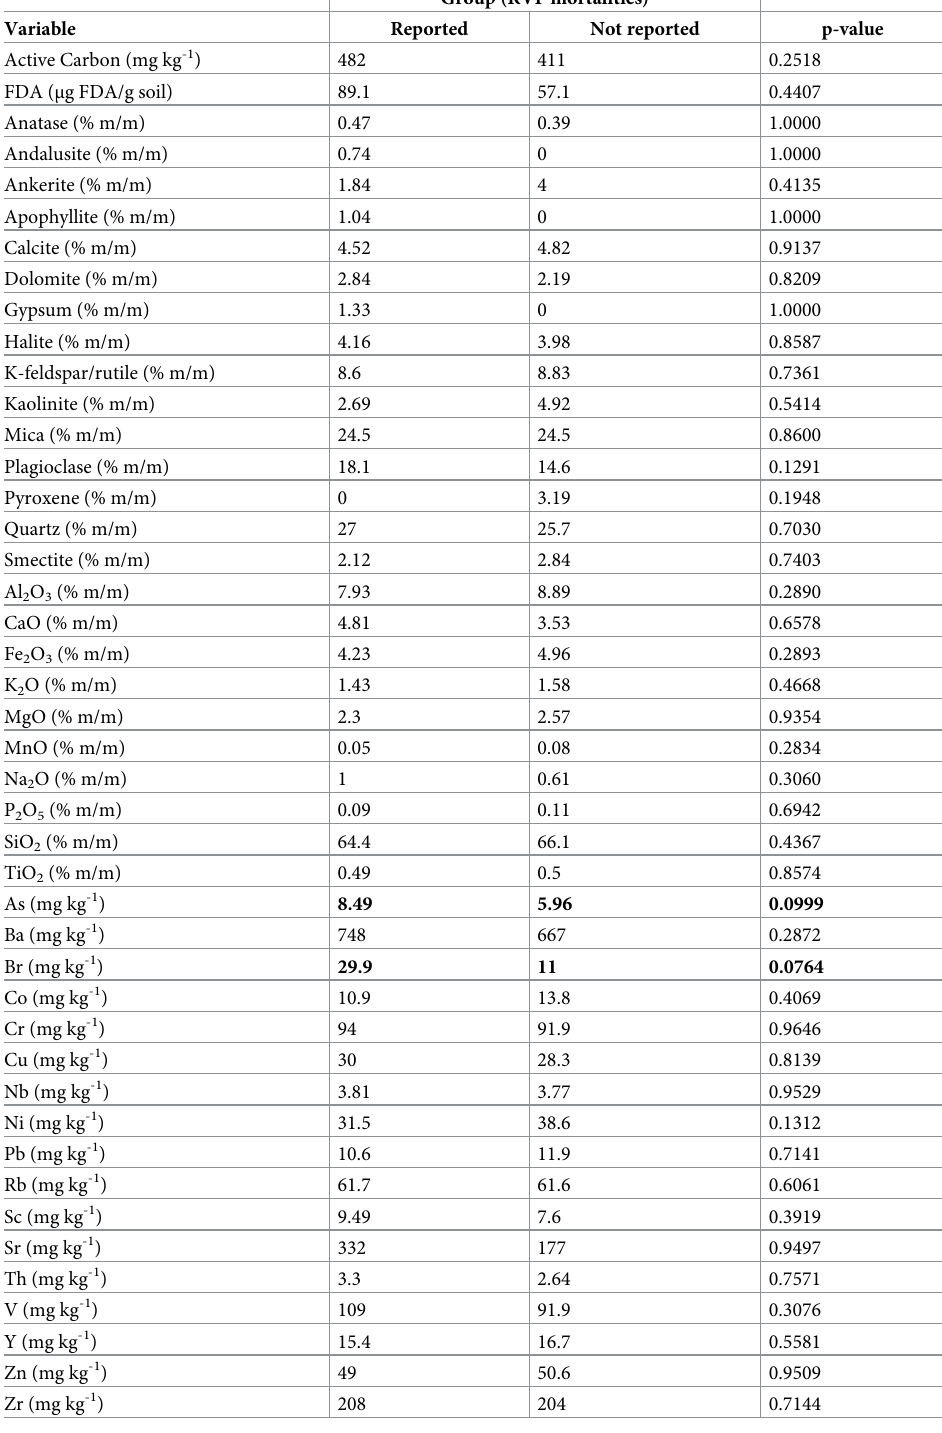
Table 3. Means of the soil microbiology, mineralogical, and elemental properties within the sampled layer across all sites where RVF mortalities were reported or not reported [21] during the 2009–2010 RVF outbreak. Signifi- cance was determined using the non-parametric van der Waerden test, and is given as the